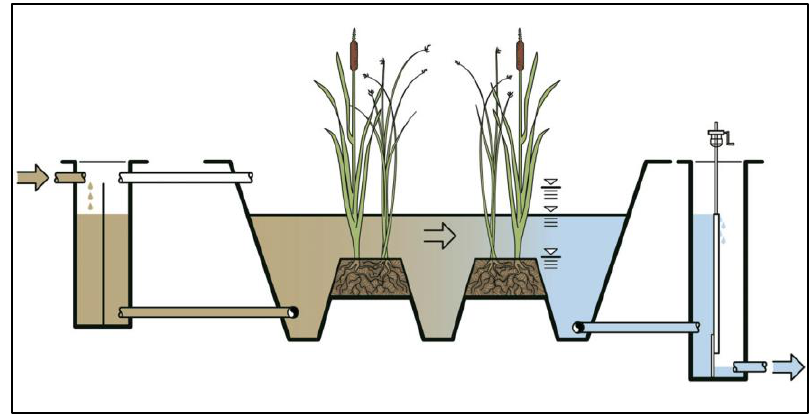
Figure 3. Subsurface horizontal flow HFCW [7].